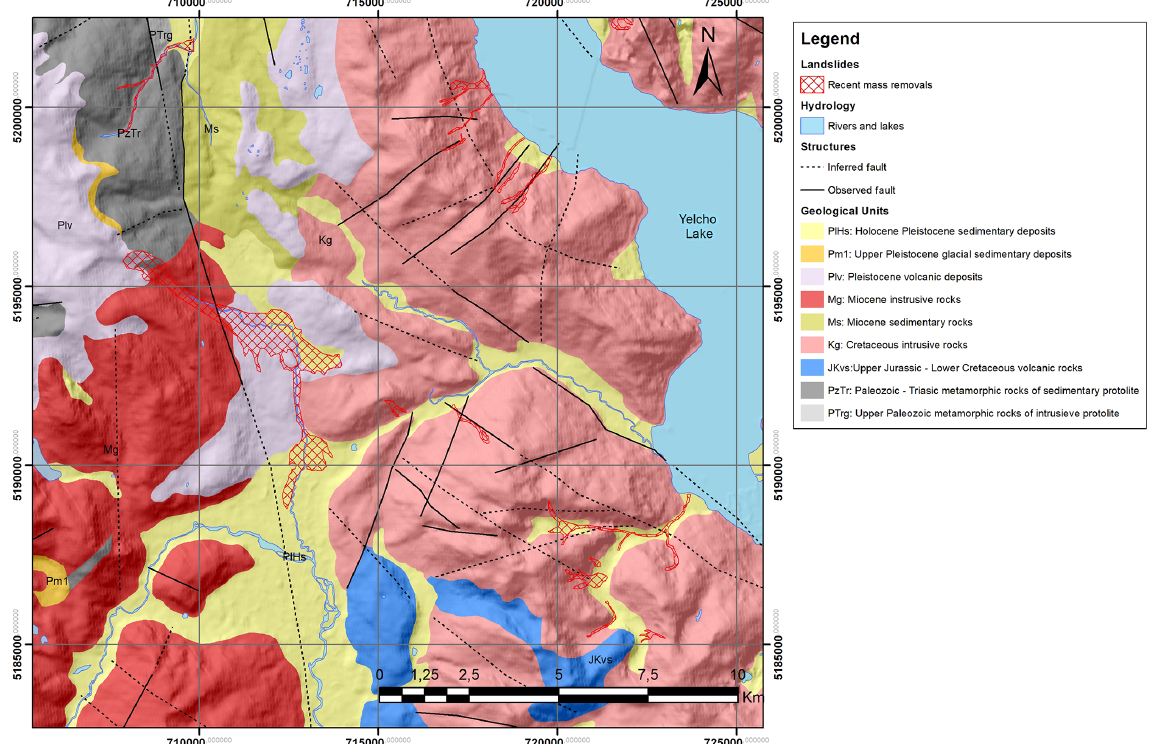
Figure 2. Geology of the study area (modified from Sernageomin,